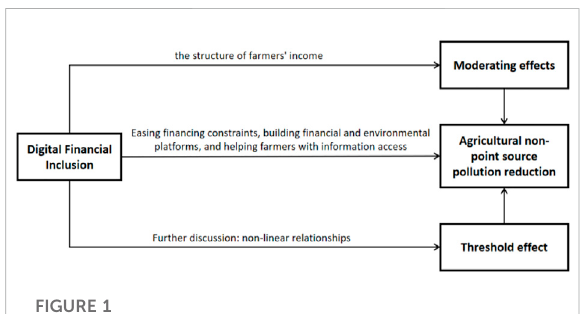
FIGURE 1 A theoretical framework diagram of digital fi nancial inclusion on agricultural non-point